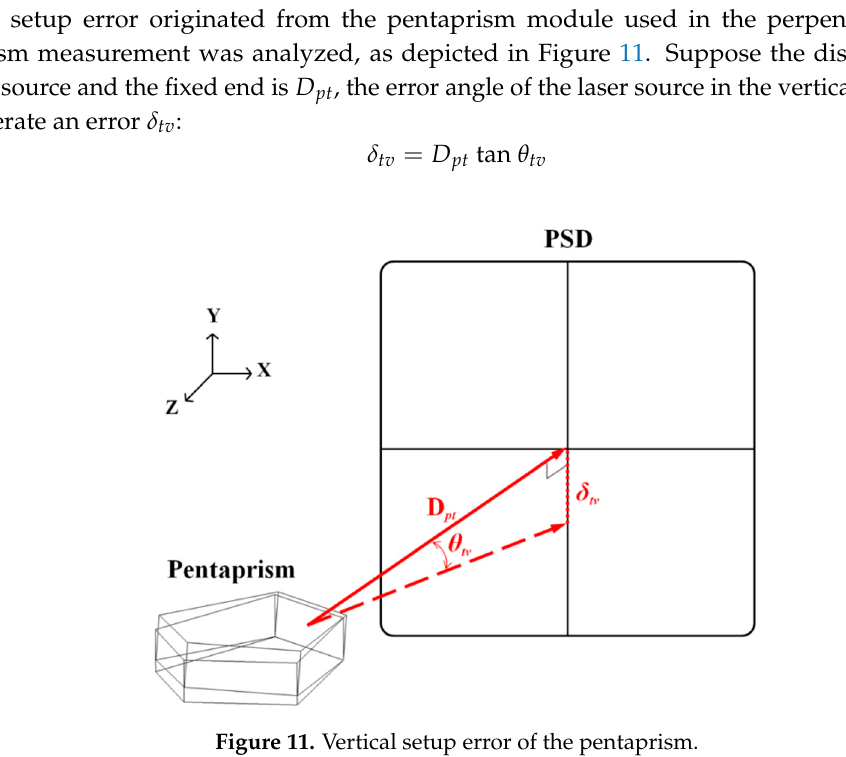
Figure 10. Position sensing detector (PSD) setup error. Table 2. Error analysis of the PSD setup .